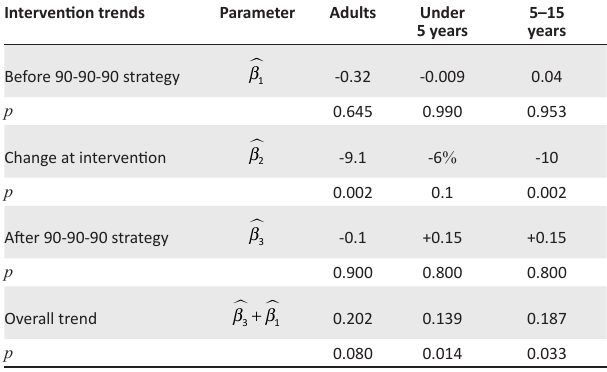
TABLE 3: Viral load suppression rate before and after the 90-90-90 strategy implementation amongst children and adults. Viral load defined at VL< 50 copies/mL. Intervention